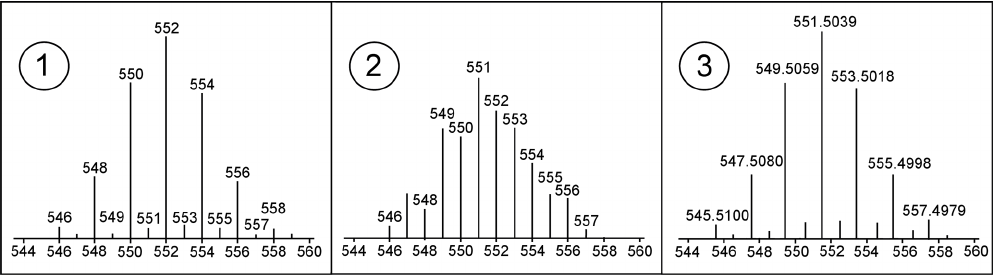
Figure 4. (1) Isotope cluster of hexabromobenzene (HBB) in NIST14, (2) own measured HBB on GC × GC-LRMS and (3) HRMS isotope cluster HBB.